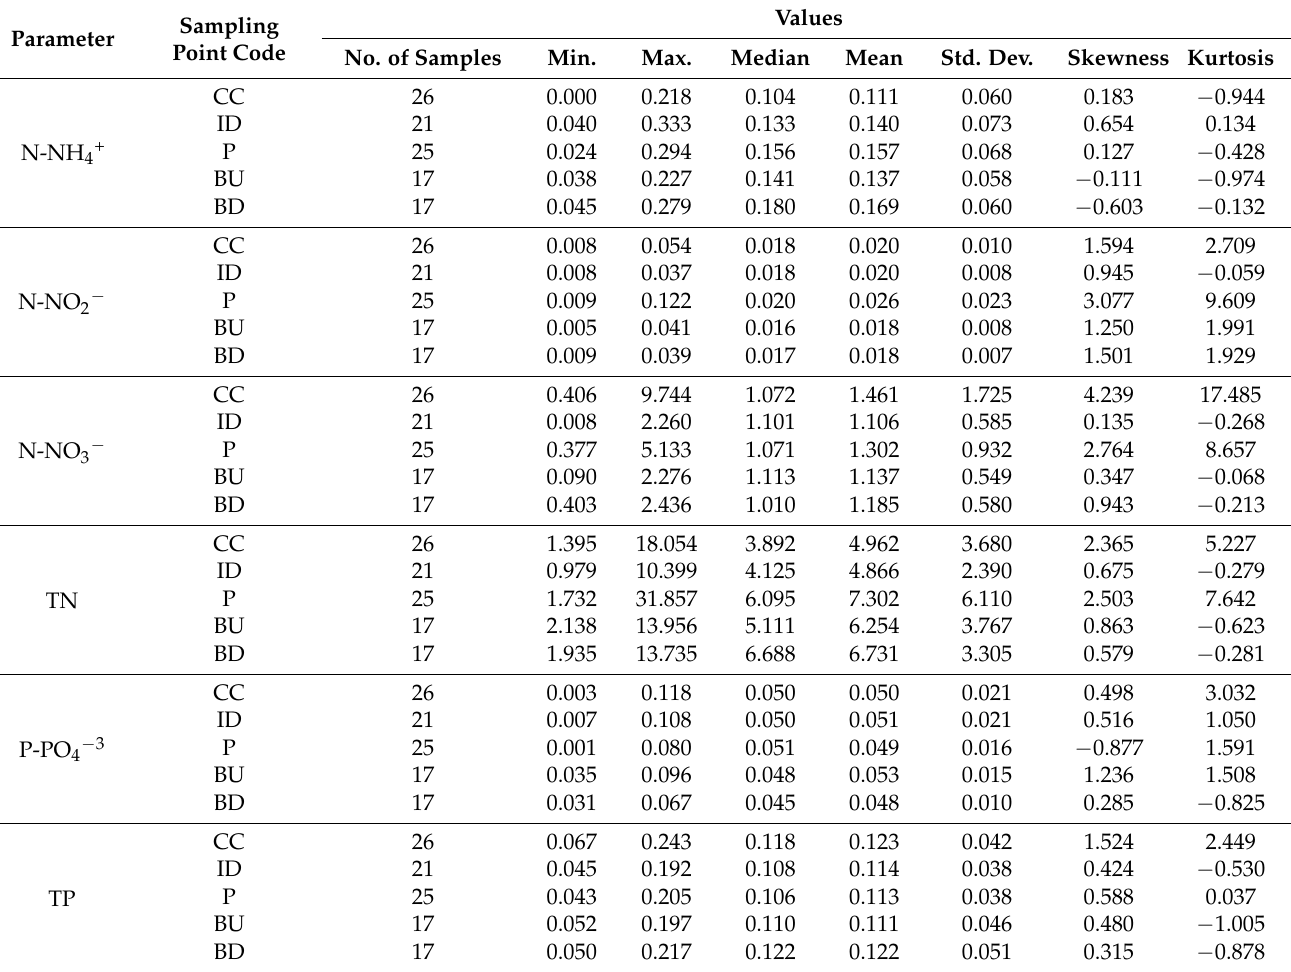
Table 5. Statistical parameters for the Chilia branch ecological status evaluation